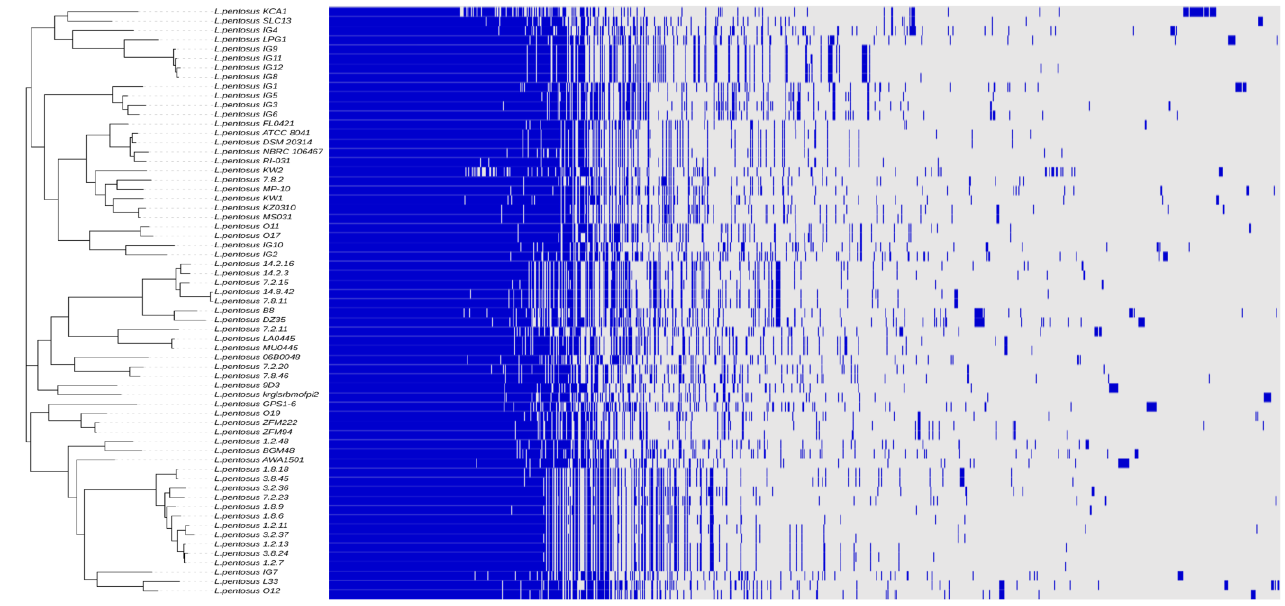
Figure 4. Hierarchical clustering and heat map of the gene matrix for the pan-genome analysis using the 63 L. pentosus strains. Blue/presence, gray/absence of the gene.